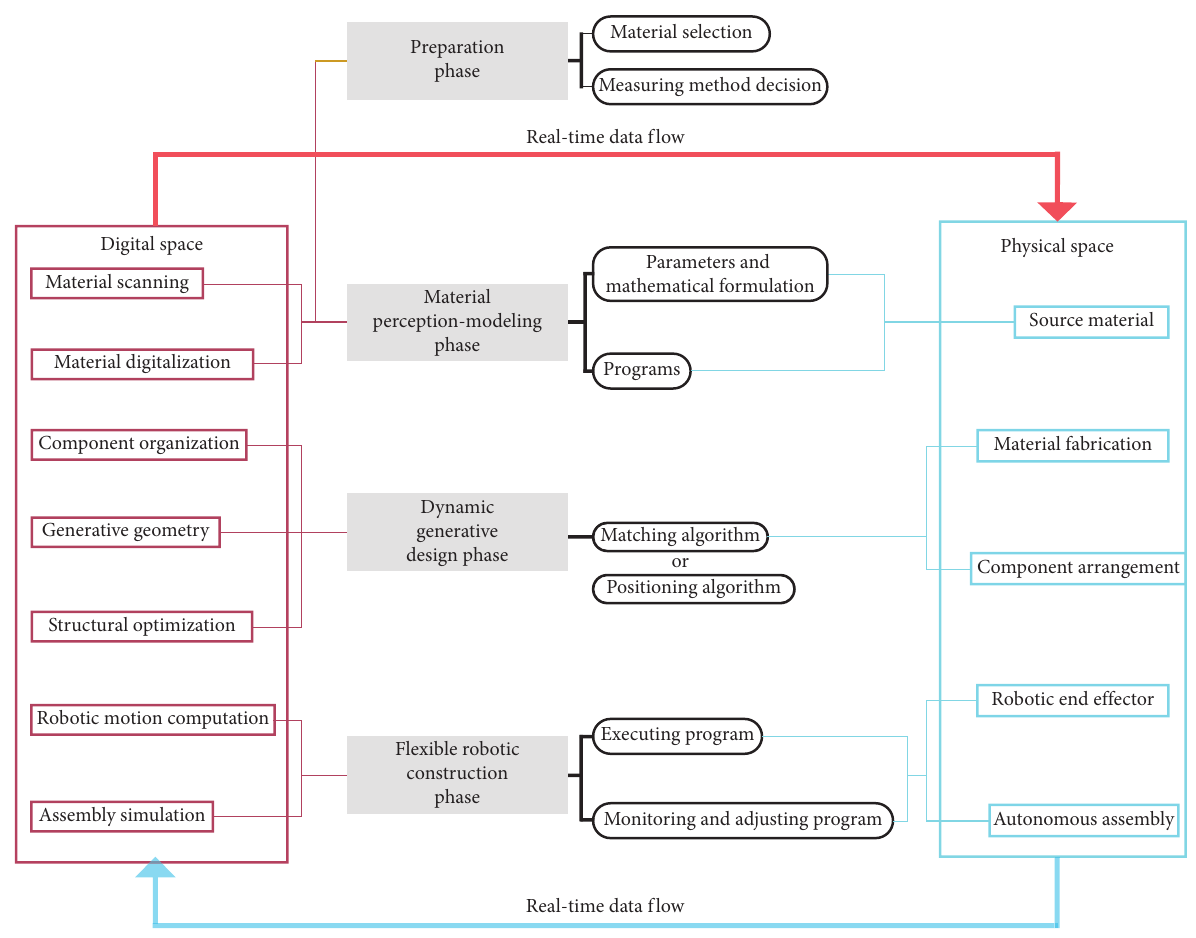
Figure 1: Digital twin framework for on-site